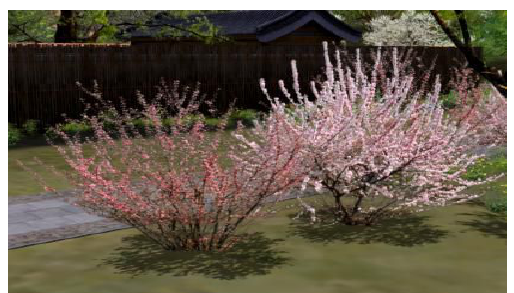
Figure 4. Permanent-surface Single-leaf Plant